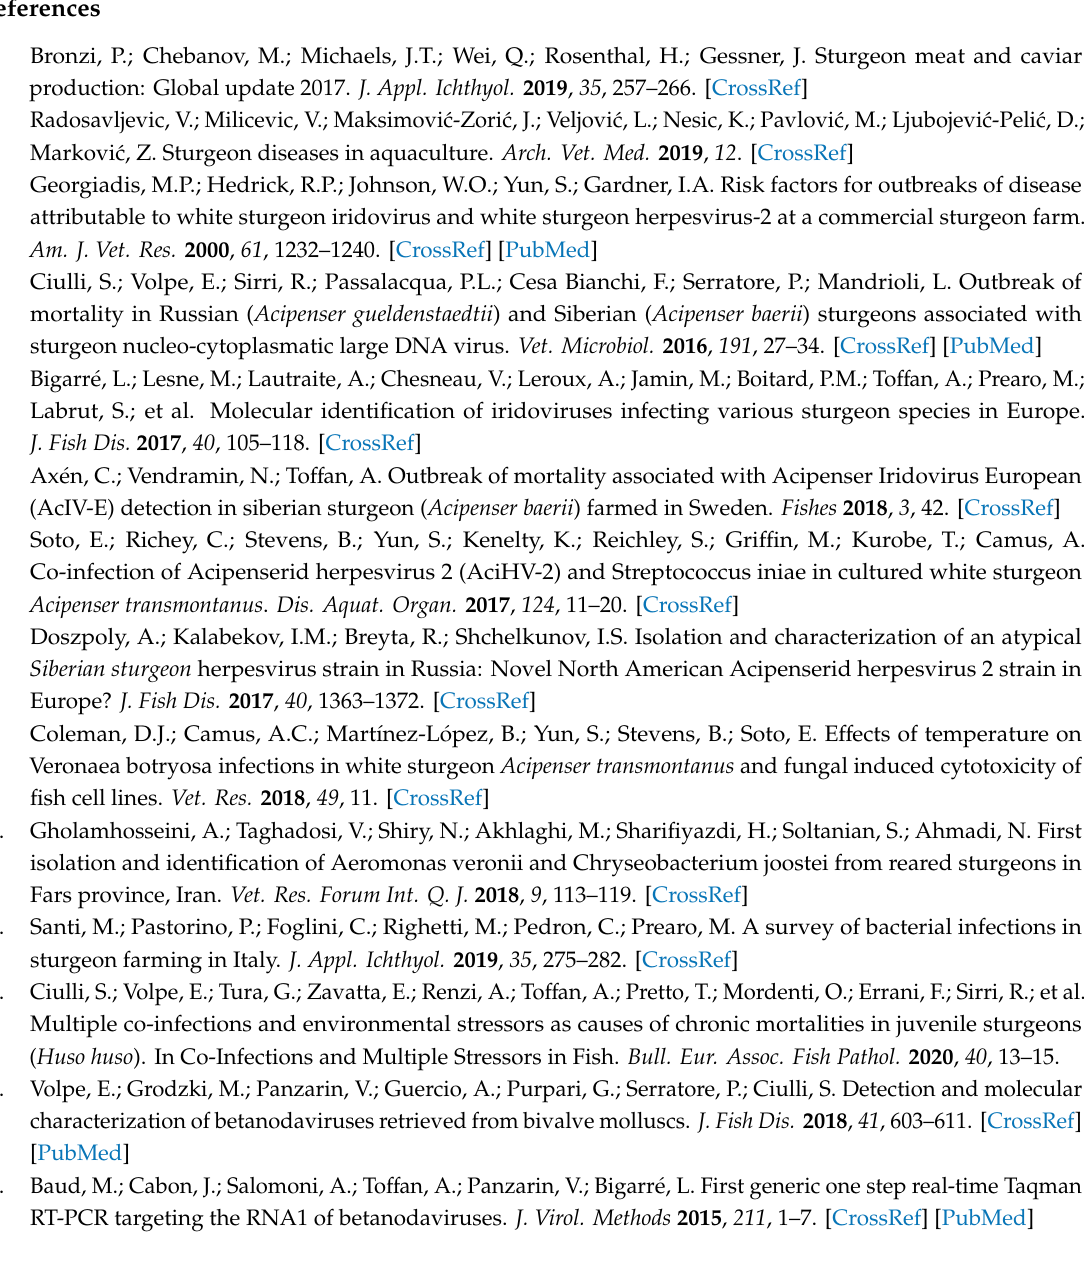
Table S1, NGS BLAST analysis results. Video S1, neurologic signs observed in diseased